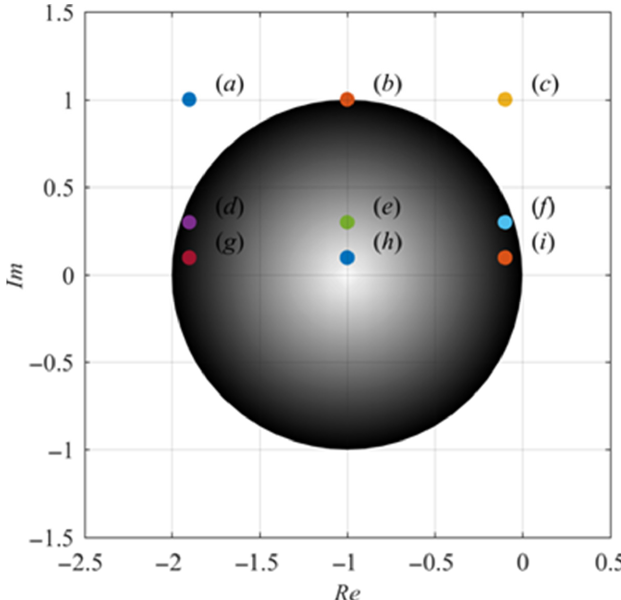
Figure 1. Stability regions of explicit Euler method and nine test points where the solution was estimated.